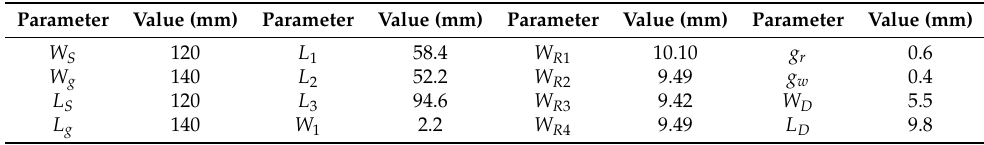
Table 3. Optimized Parameters of Iteration 2 design and